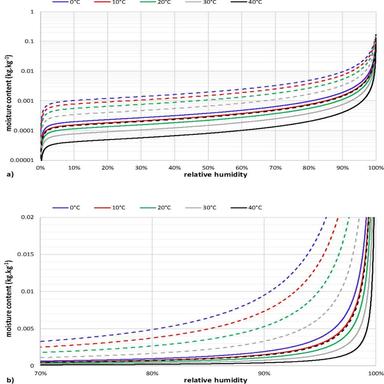
Predicted main adsorption and desorption curves at different temperatures – solid lines: main adsorption and dashed lines: main desorption. In Fig. 12a, a semilogarithmic scale is used and in Fig. 12b a no-logarithmic scale.